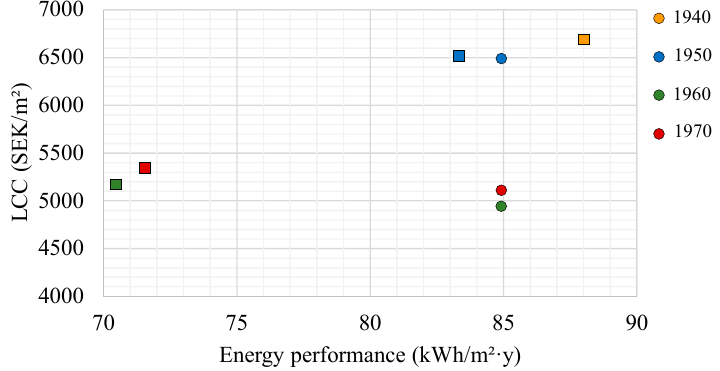
Figure 9. LCC for renovation to energy performance requirement in newly constructed building (circles), and highest energy performance achieved with all of the EEMs included in the analysis (squares).